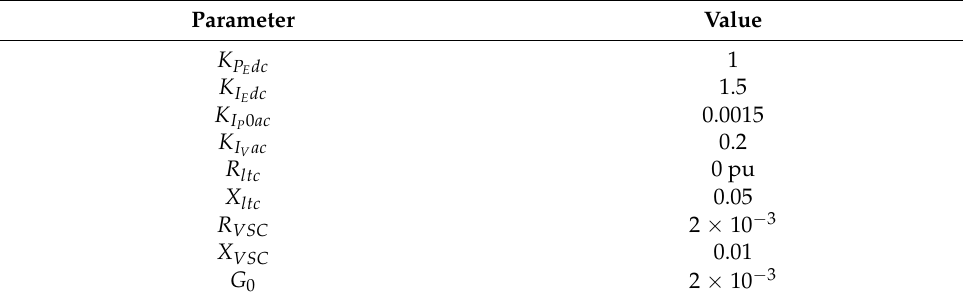
Table 2. Gains of StatCom controller.